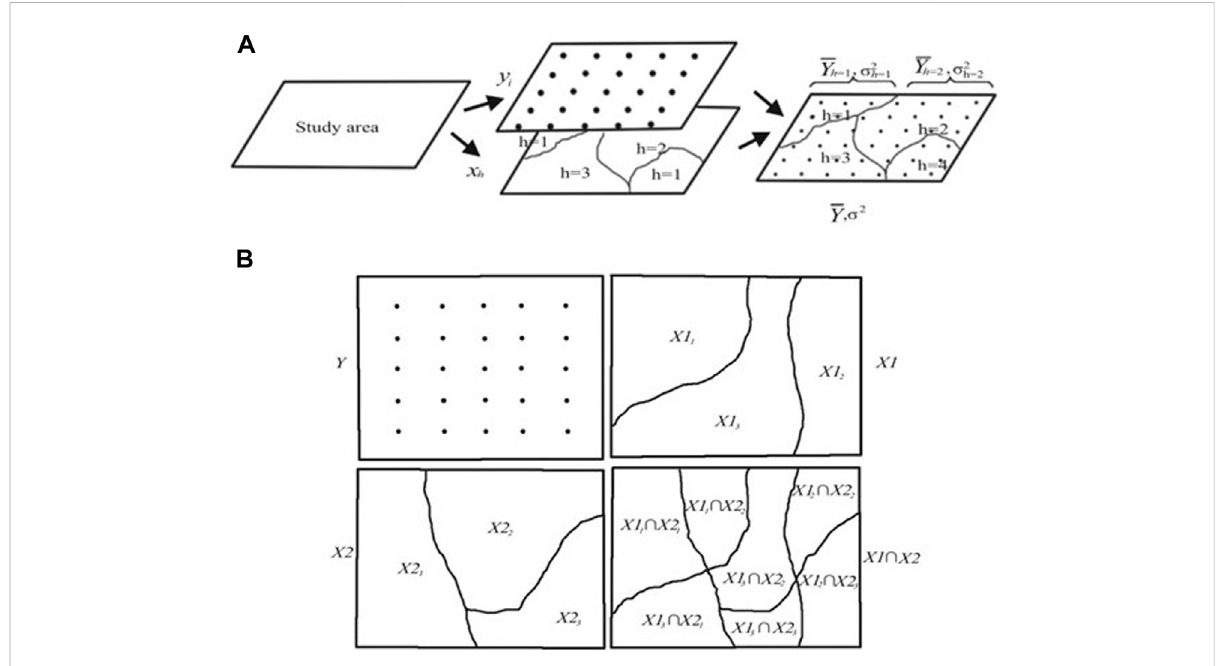
FIGURE 3 Rationale of the geographical detector (Wang et al., 2010; Wang and Xu, 2017). (A) Detection of driving forces and (B) detection of interaction.